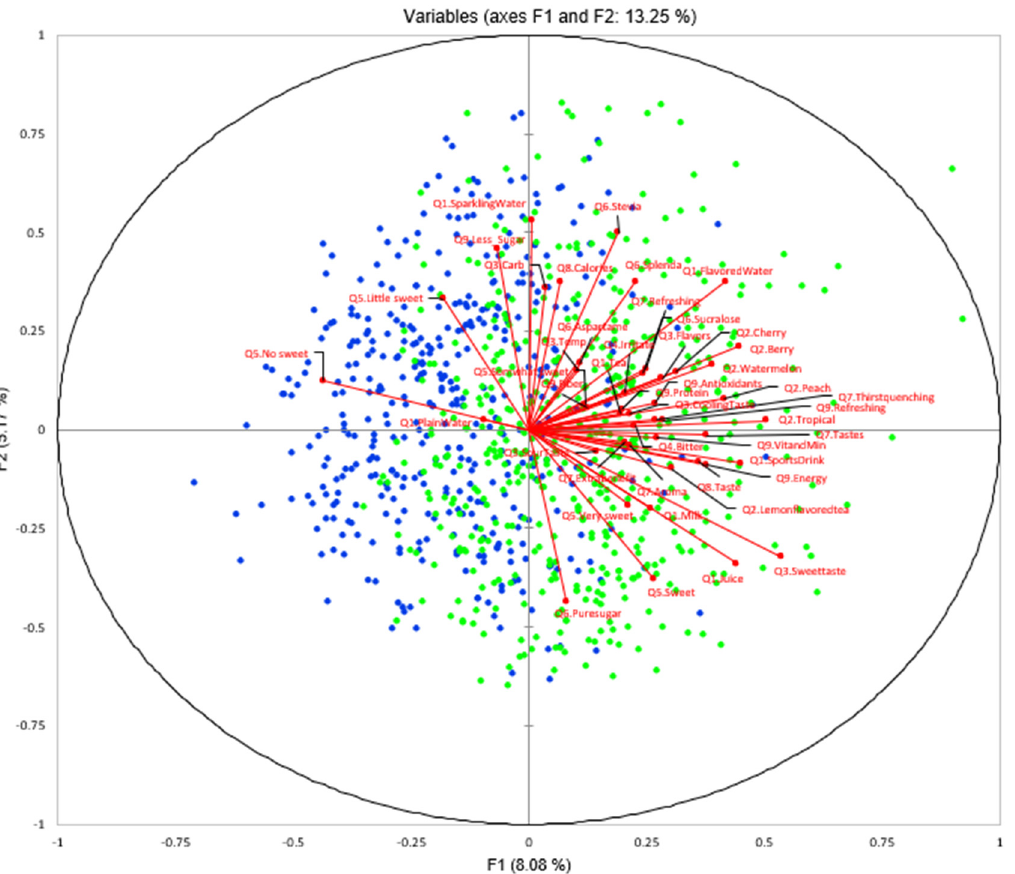
Figure 16. Internal preference mapping (IPM) of two clusters of consumers (blue diamonds represent cluster 1 with n = 410 and green squares represent cluster 2 with n = 491) characterized by nine survey questions (Q1–Q9, 41 selection total), which were selected by significance of chi-square analysis between two clusters.